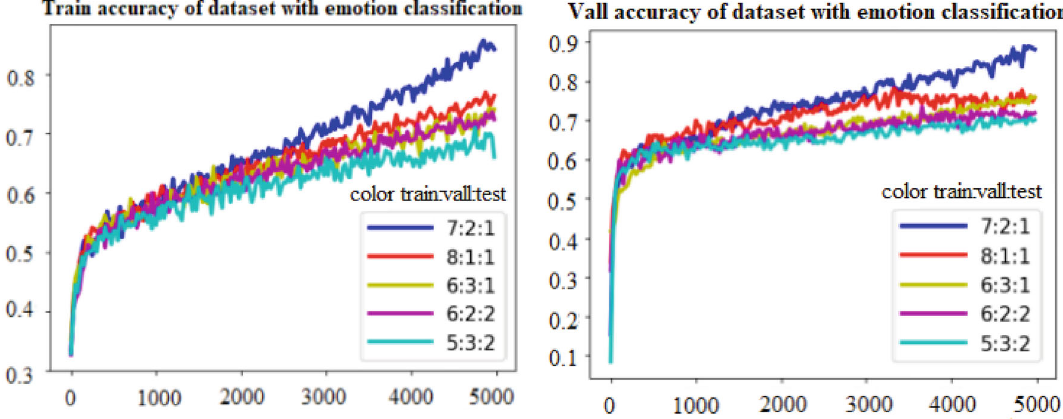
Fig. 9 Comparing of dataset with emotion classification accuracy